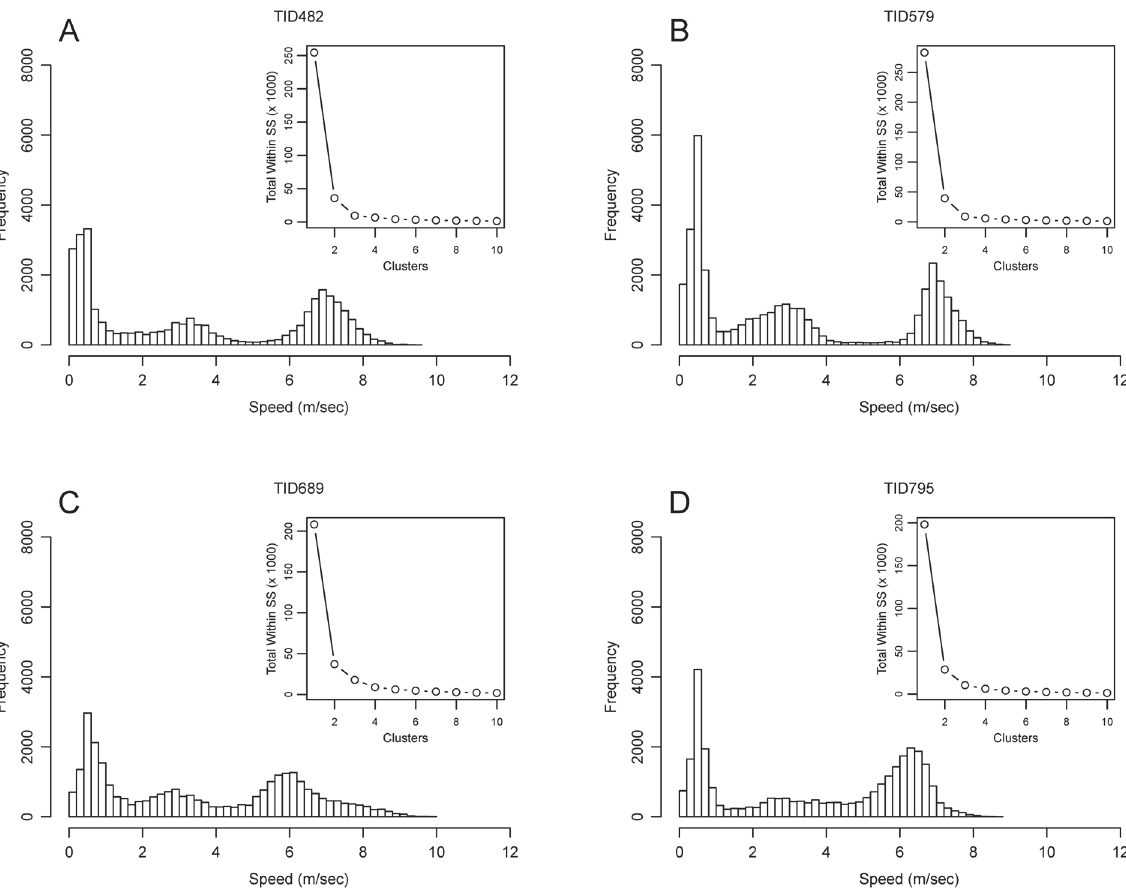
Fig 4. Frequency distribution of speeds. Plots are for the trips in Fig. 2. Histograms show the tri-model pattern characteristic of all the trips in the sample. The inset scree plots show an inflection point at three groups indicating that fewer clusters have a sharply increased total within sum of squares.